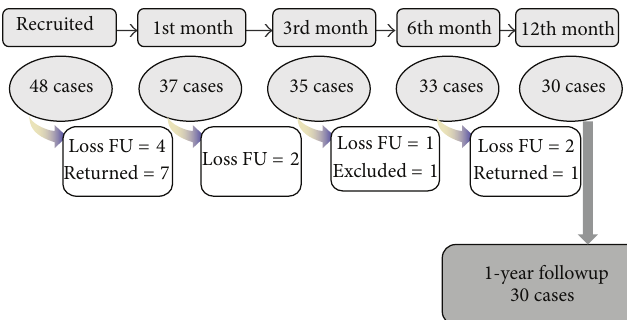
Figure 4: Trial overview (October 2009–July 2012).